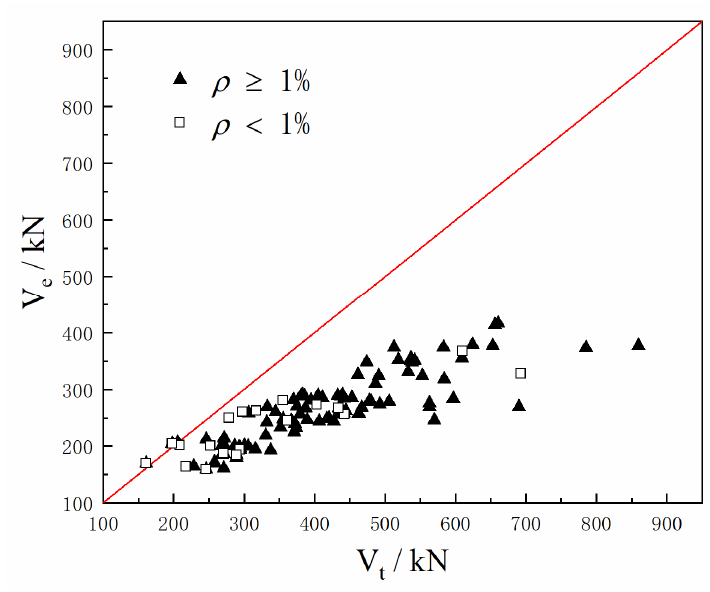
Figure 12. Calculation result of the uncorrected bearing capacity equation.